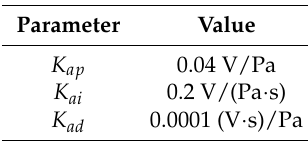
Figure 8. Block diagram of pressure control. Table 1. Control parameters.